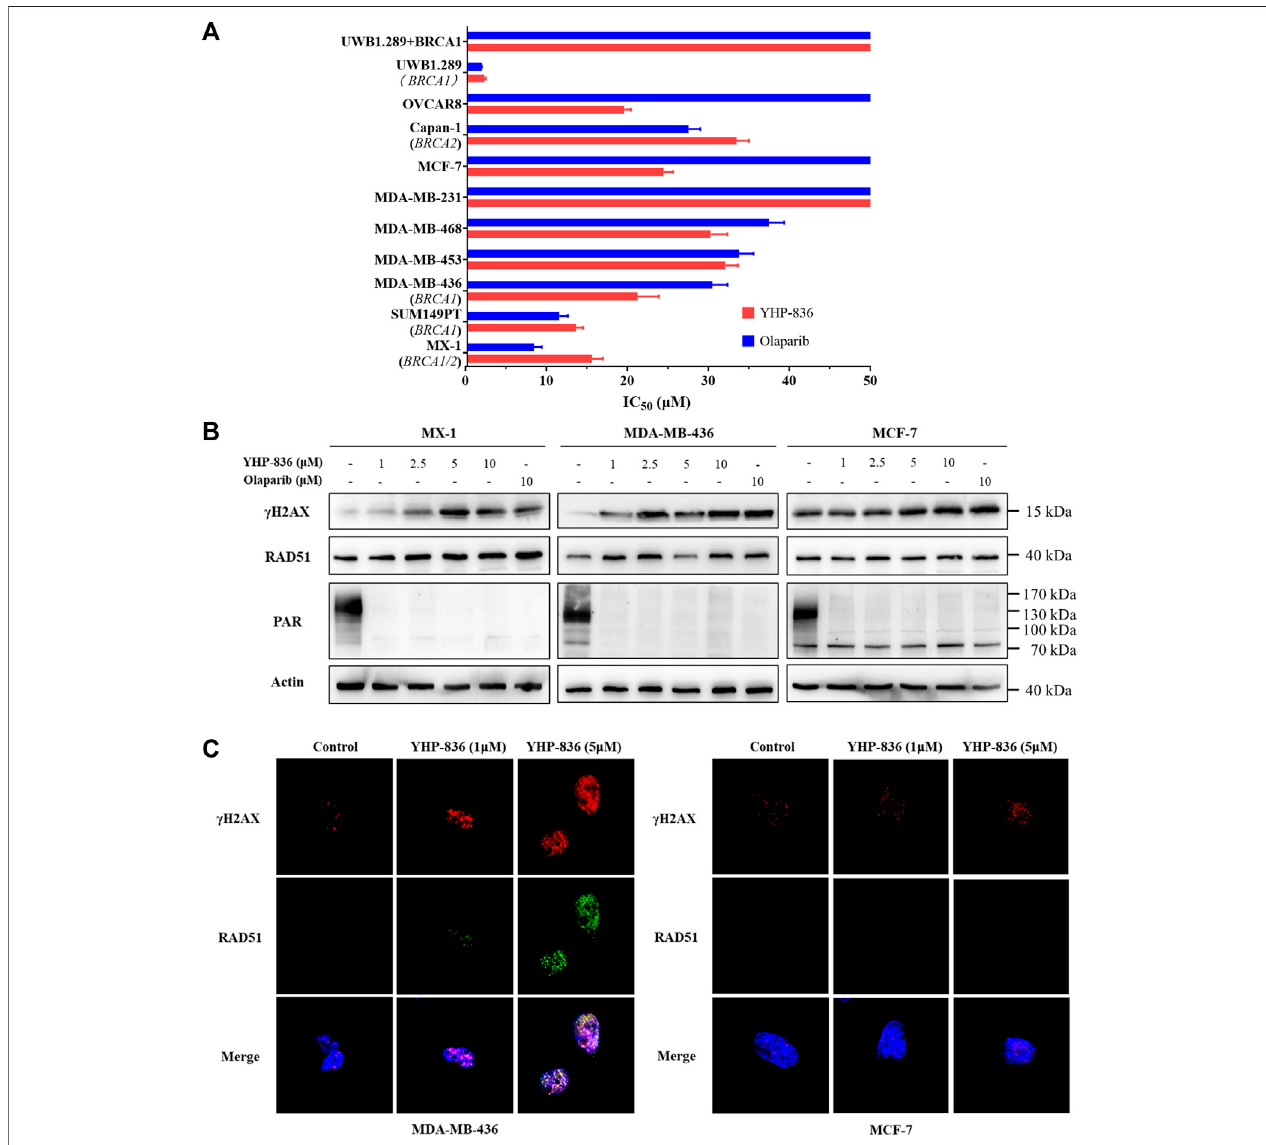
FIGURE2| ThecytotoxicityofYHP-836. (A) ThecytotoxicactivityofYHP-836intumorcelllines.IC 50 valueswereindicatedasmean±SD. (B) YHP-836increased theDNAdamagemarkerinbreastcancercells.ThecellswereexposedtoYHP-836(1,2.5,5,and10 μ M)orolaparib(10 μ M)for24 h. (C) Immuno fl uorescentstainingof γ H2AX and RAD51 in breast cancer cells. Exposure to indicated concentrations of YHP-836 (1 and 5 μ M) for 24 h.